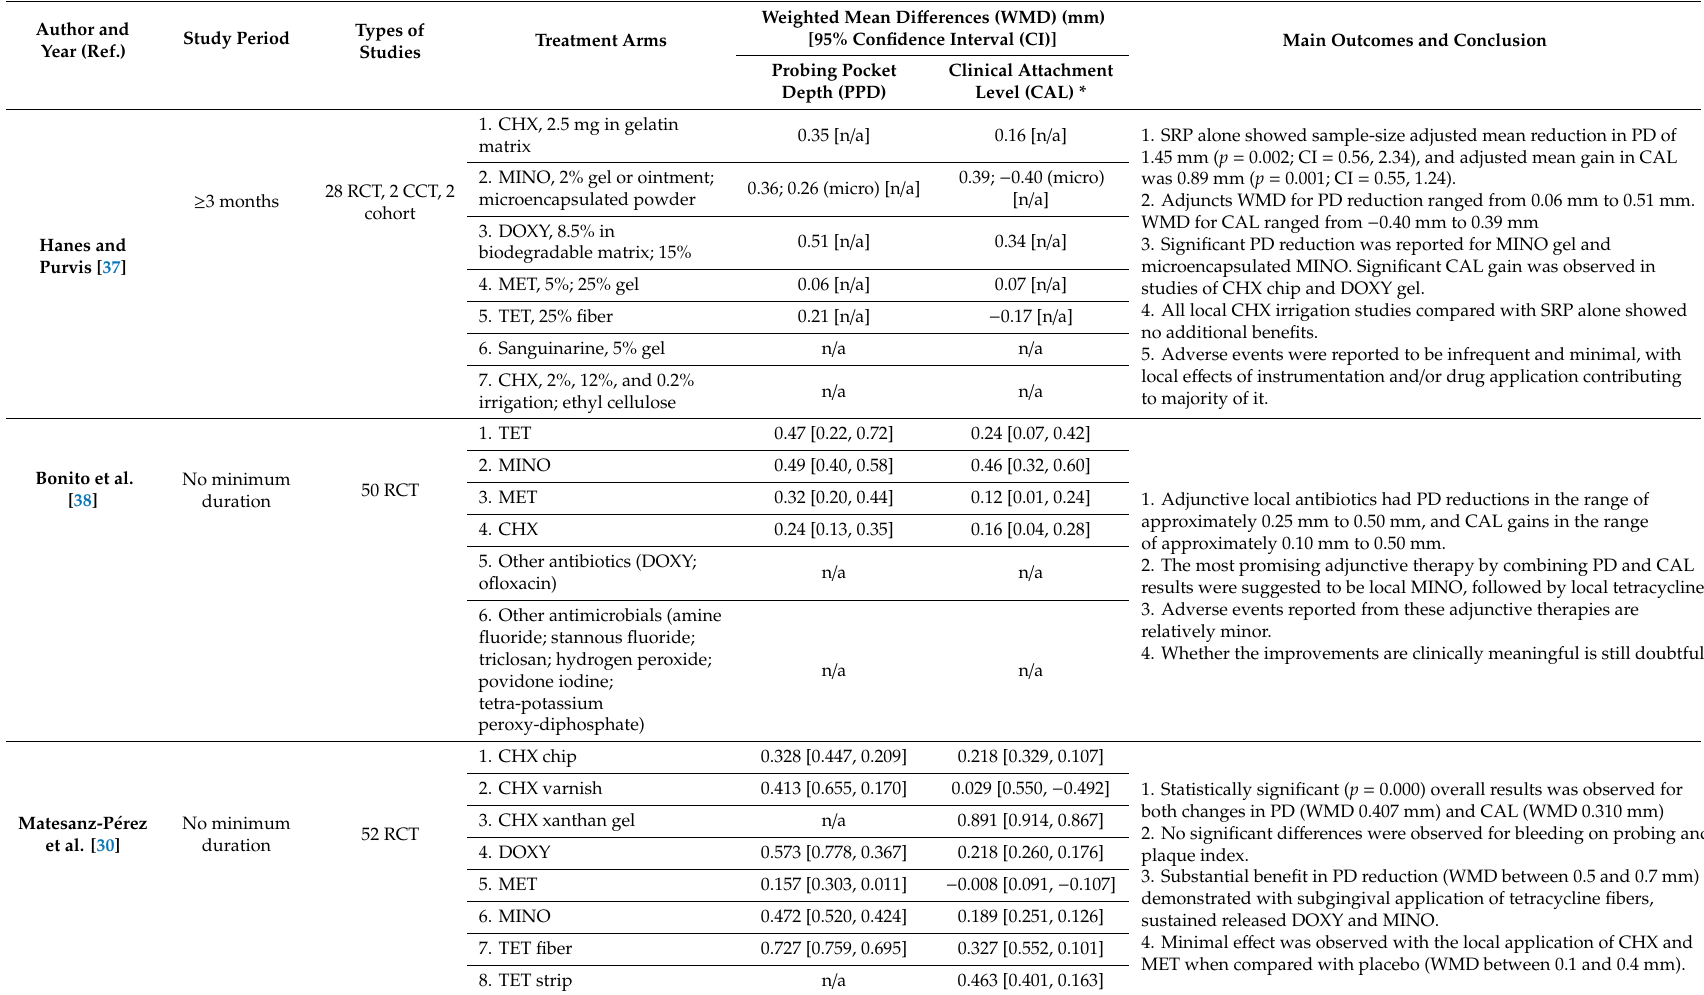
Table 2. Summary table of systematic reviews with meta-analyses comparing clinical e ffi cacy of di ff erent LDA for nonsurgical periodontal therapy (scaling / root planning